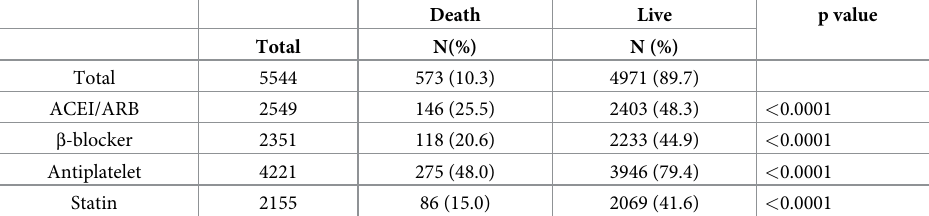
Table 10. The mortality of patients with and without prescription medication at the end of follow-up.